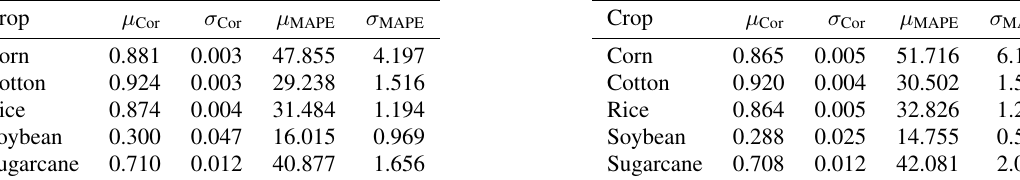
Table 3. Model performance with noise layer in dynamic features. µ Cor represents the average value of correlation metric, σ Cor represents the standard deviation of the correlation metric. Similarly, µ MAPE and σ MAPE represent the average and standard deviation of the MAPE . Averages were computed over thirty independent executions.